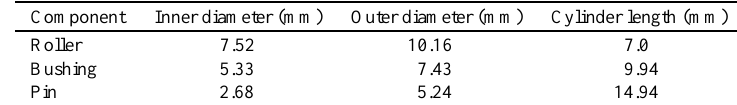
Fig. 1. Finite element mesh of the simulated chain drive. Table 2 Dimension of the chain roller components